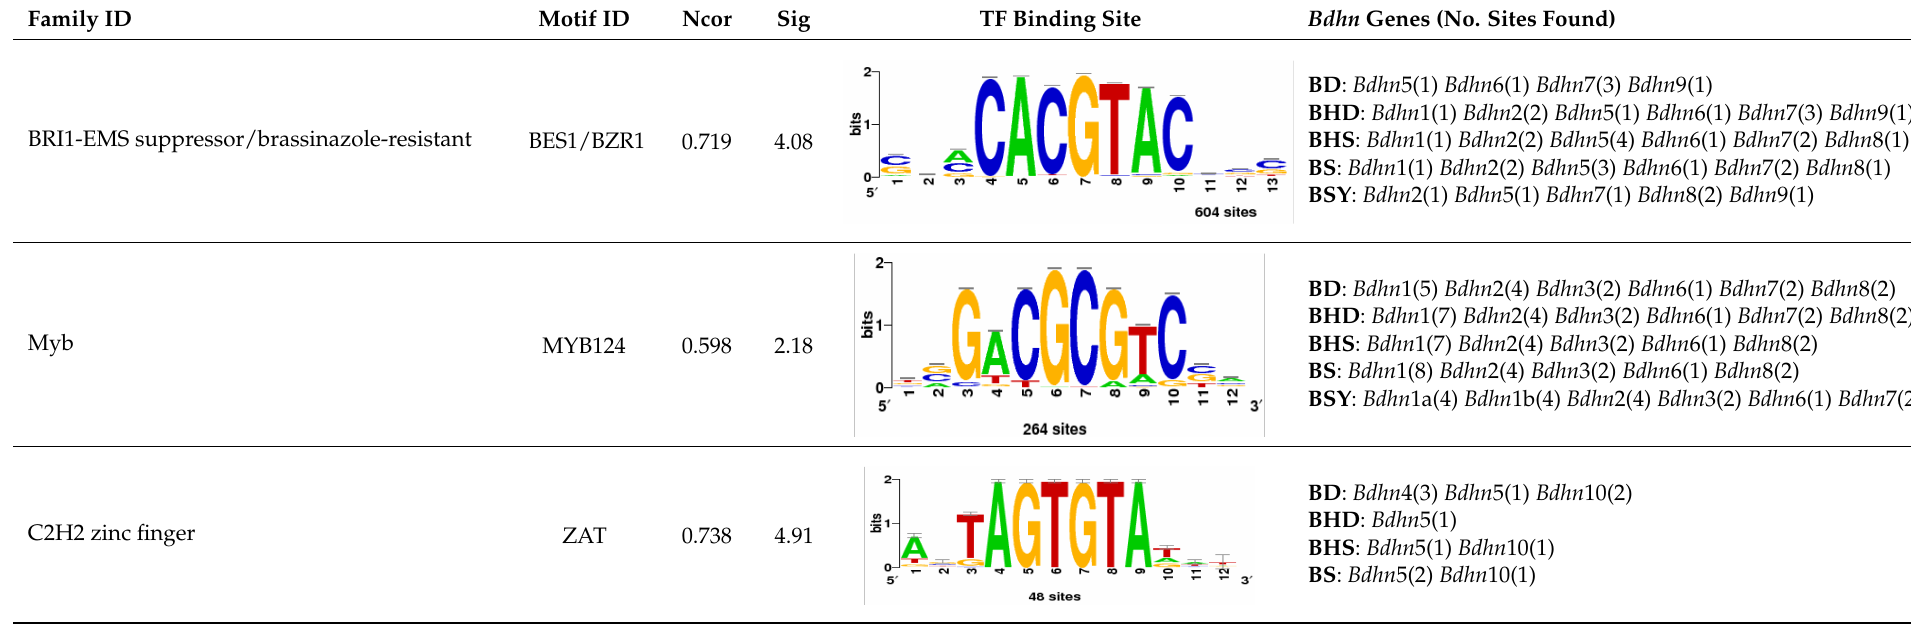
Table 2. Upstream putative cis -regulatory elements (CREs) found in the promoter region (–500-to-+200 bp) of the Bdhn genes of Brachypodium distachyon , B. stacei , B. hybridum (subgenomes D and S), and B. sylvaticum using Rsat::plants tools and the corresponding reference genome as background. Family identification, motif code (ID), N-cor (normalized correlation), and Sig (significance value) for the highest hit, matches to transcription factor (TF) binding sites, and Bdhn genes with the number of sites found within each species and gene. Species and reference genomes: BD, B. distachyon Bd21; BS, B. stacei ABR114; BHD, B. hybridum subgenome D ABR113; BHS, B. hybridum subgenome S ABR113; BS, B. sylvaticum Ain1. Mapping positions of these cis -regulatory motifs are indicated in Figure